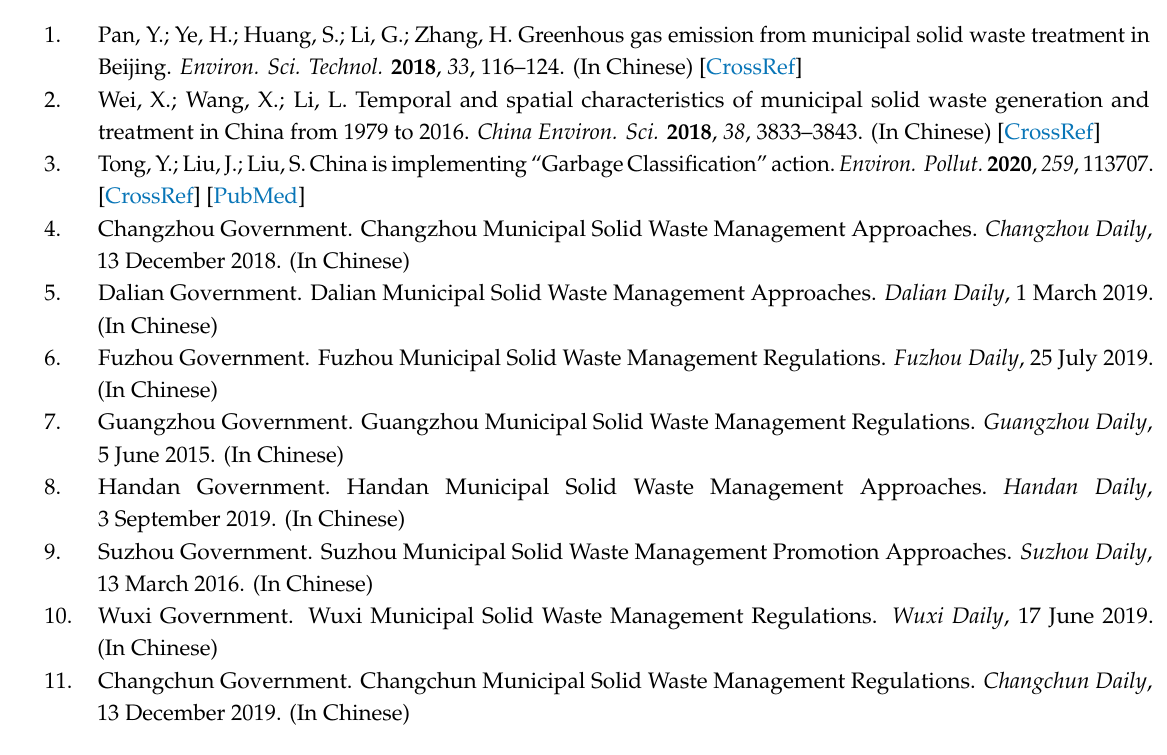
Table S1: Comparative Midpoint Life Cycle Impact Assessment Results, Table S2: Comparative Single Scored Life Cycle Impact Assessment Results, Table S3: Uncertainty analysis results for single scored life cycle impact assessment, Table S4: Uncertainty analysis results for comparison between S-1 and S-2, midpoint,1 p ‘S-2’ (A) minus 1 p ‘S-1’ (B), Table S5: Uncertainty analysis results for comparison between S-1 and S-3, midpoint,1 p